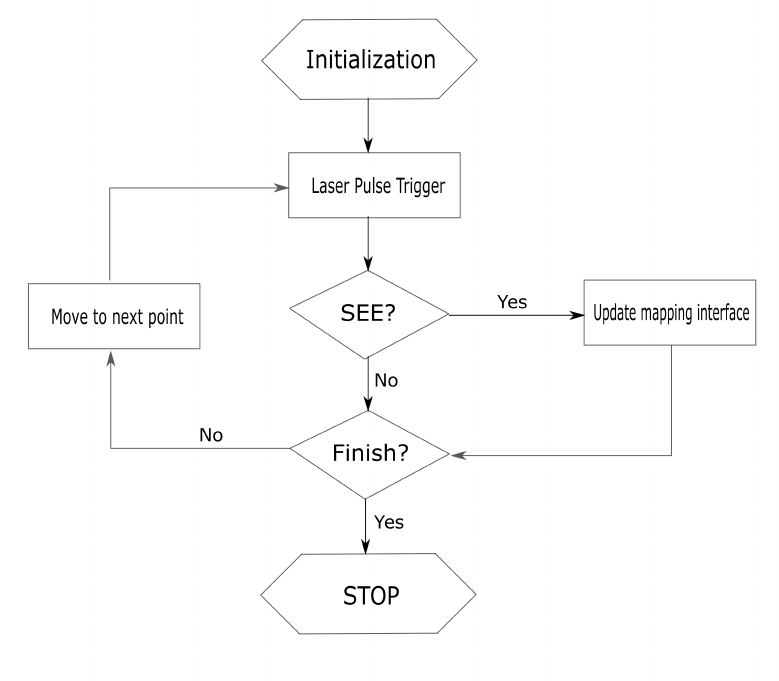
Figure 7. Data flow of whole mapping system.